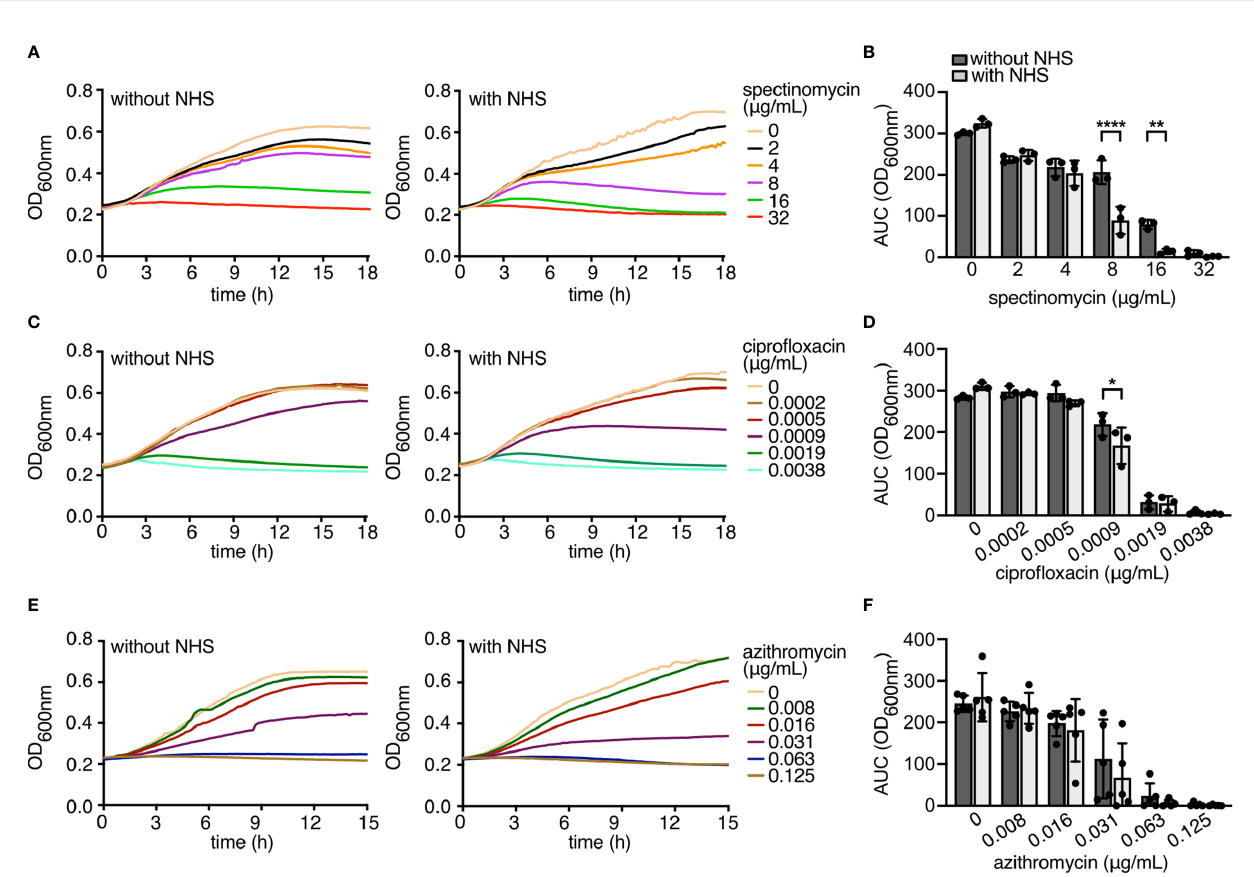
FIGURE 1 | NHS potentiates antibiotic killing of N. gonorrhoeae FA1090. (A, C, E) FA1090 gonococci were incubated at 37°C with orbital shaking overnight +/- 10% NHS and increasing concentrations of antibiotics: spectinomycin (A) , cipro fl oxacin (C) and azithromycin (E) ; growth of bacteria was monitored by measuring OD 600nm every 10 min. (B, D, F) Area under the curve (AUC) of OD 600nm were calculated for each concentration of antibiotics. Bars display mean+/-SD, with circles indicating each of 3 (A – D) or 5 (E, F) independent repeats. Differences among samples were compared using two-way ANOVA with Sidak ’ s multiple-comparison test. *p < 0.05, **p < 0.01, ****p <